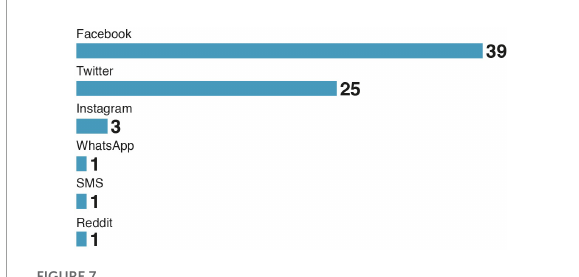
FIGURE7 Number of papers published by type of social media studied in the sample.